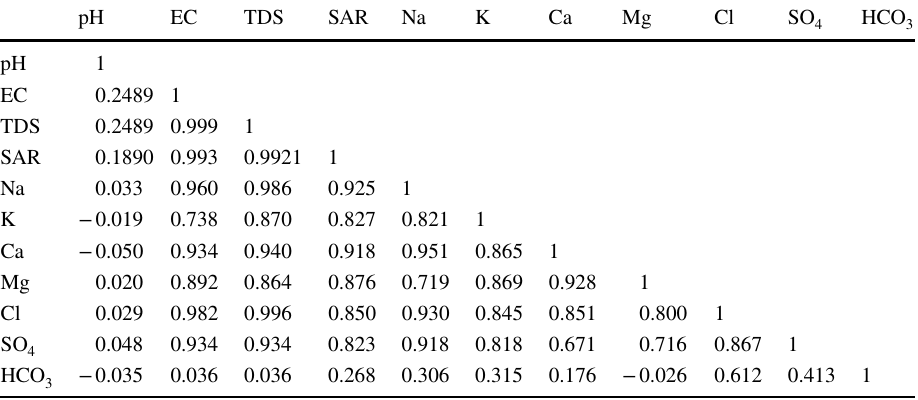
Table 2 Correlation matrix analysis result of the groundwater quality